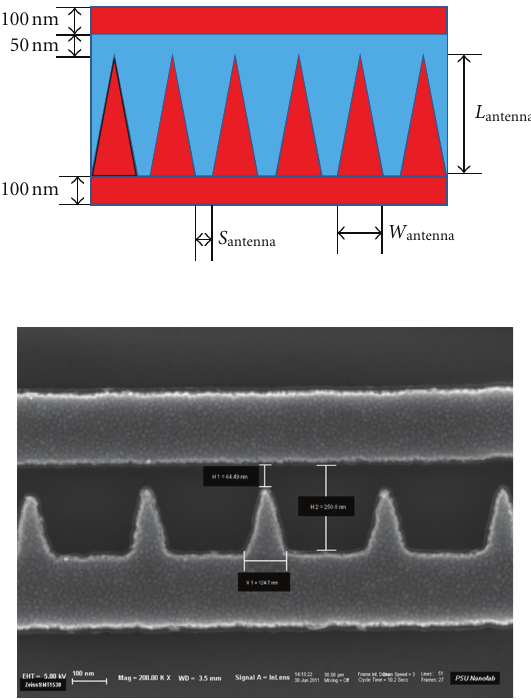
Figure 21: Schematic (top) and SEM image (bottom) of the top view for the triangular